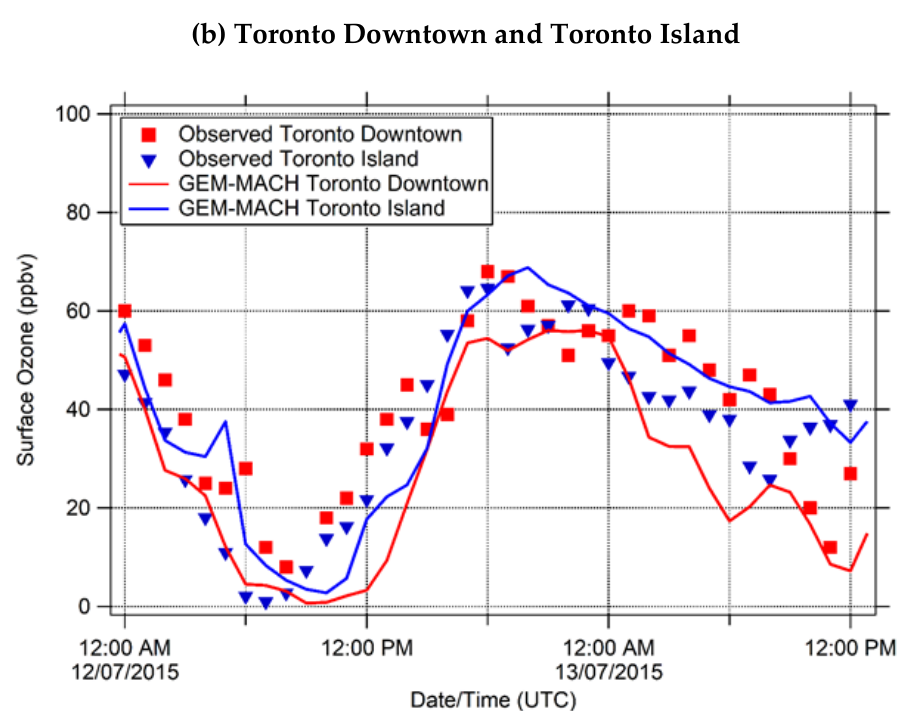
Figure 12. Observed and modelled O 3 time series for Toronto North (red, panel a ), Newmarket (blue, panel a ), Toronto downtown (red, panel b ) and Toronto Island (blue, panel b ).